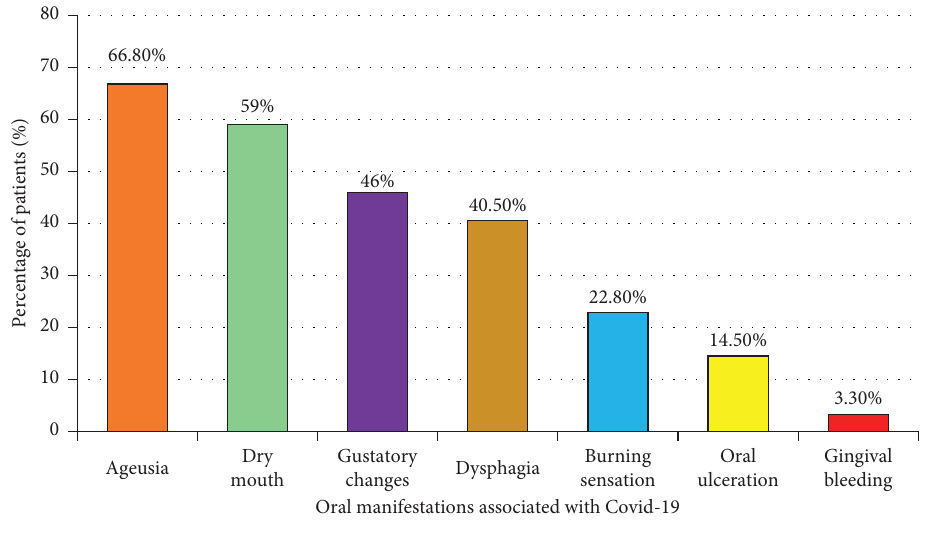
Figure 1: Percentage of oral manifestations.